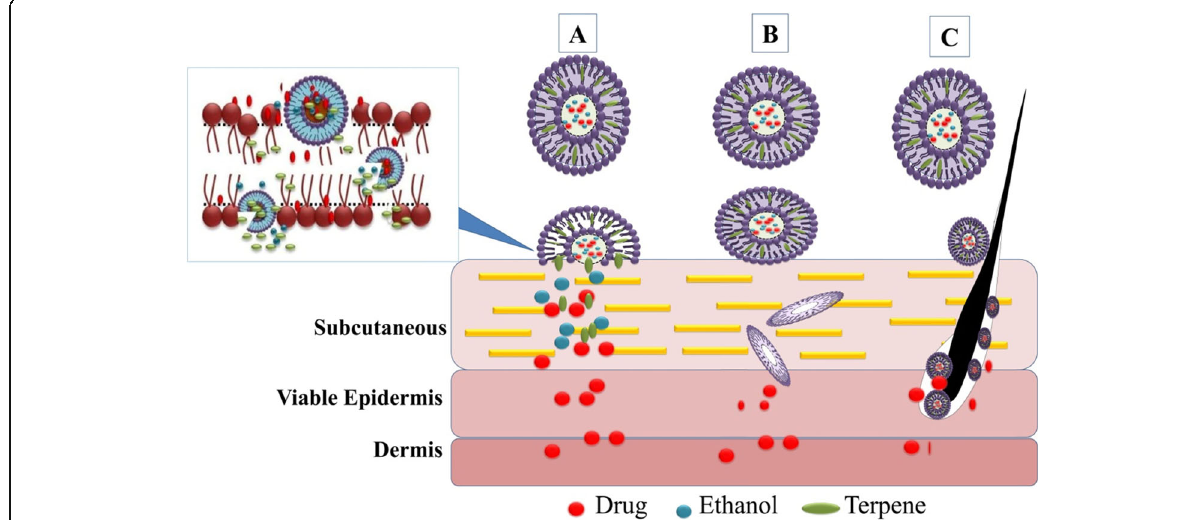
Fig. 6 Penetration mechanism of invasomes through SC ( a ) enhanced permeation (ethanol and terpene disrupt the tight packing of the SC lipids); b intact penetration of invasomes, and ( c ) trans-appendageal